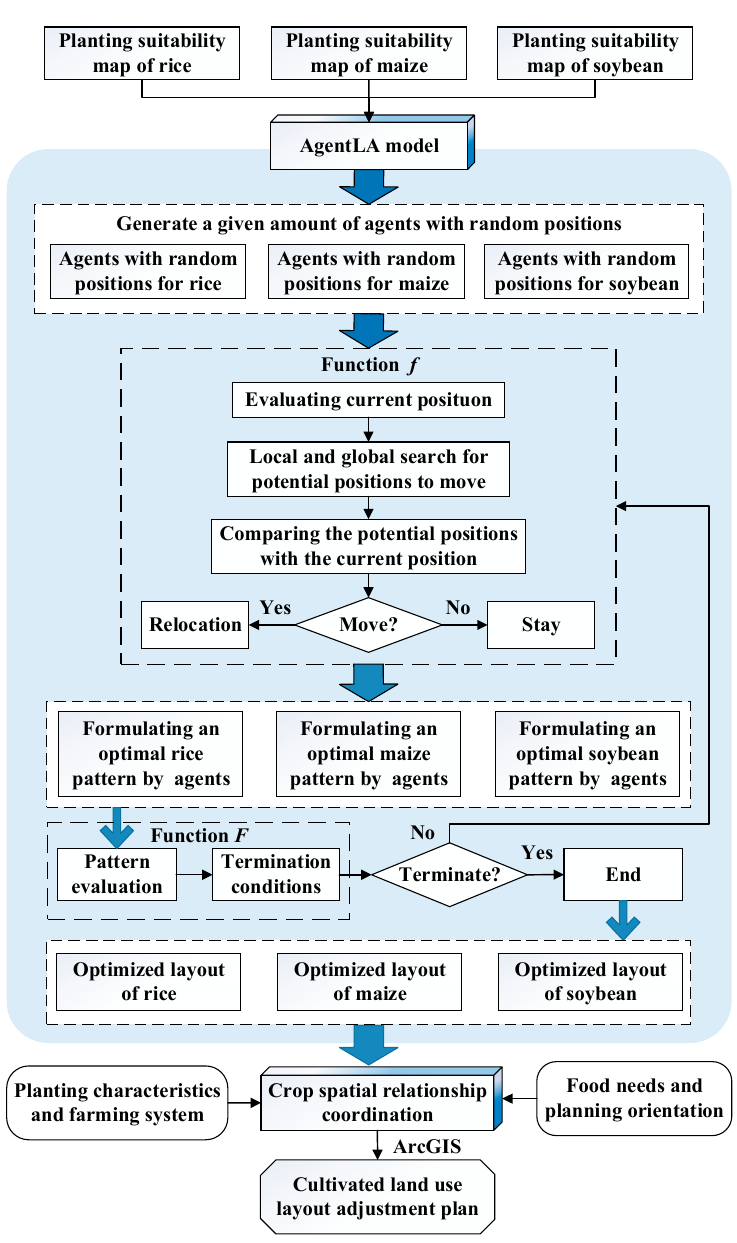
Figure 2. Procedure of cultivated land use layout adjustment.